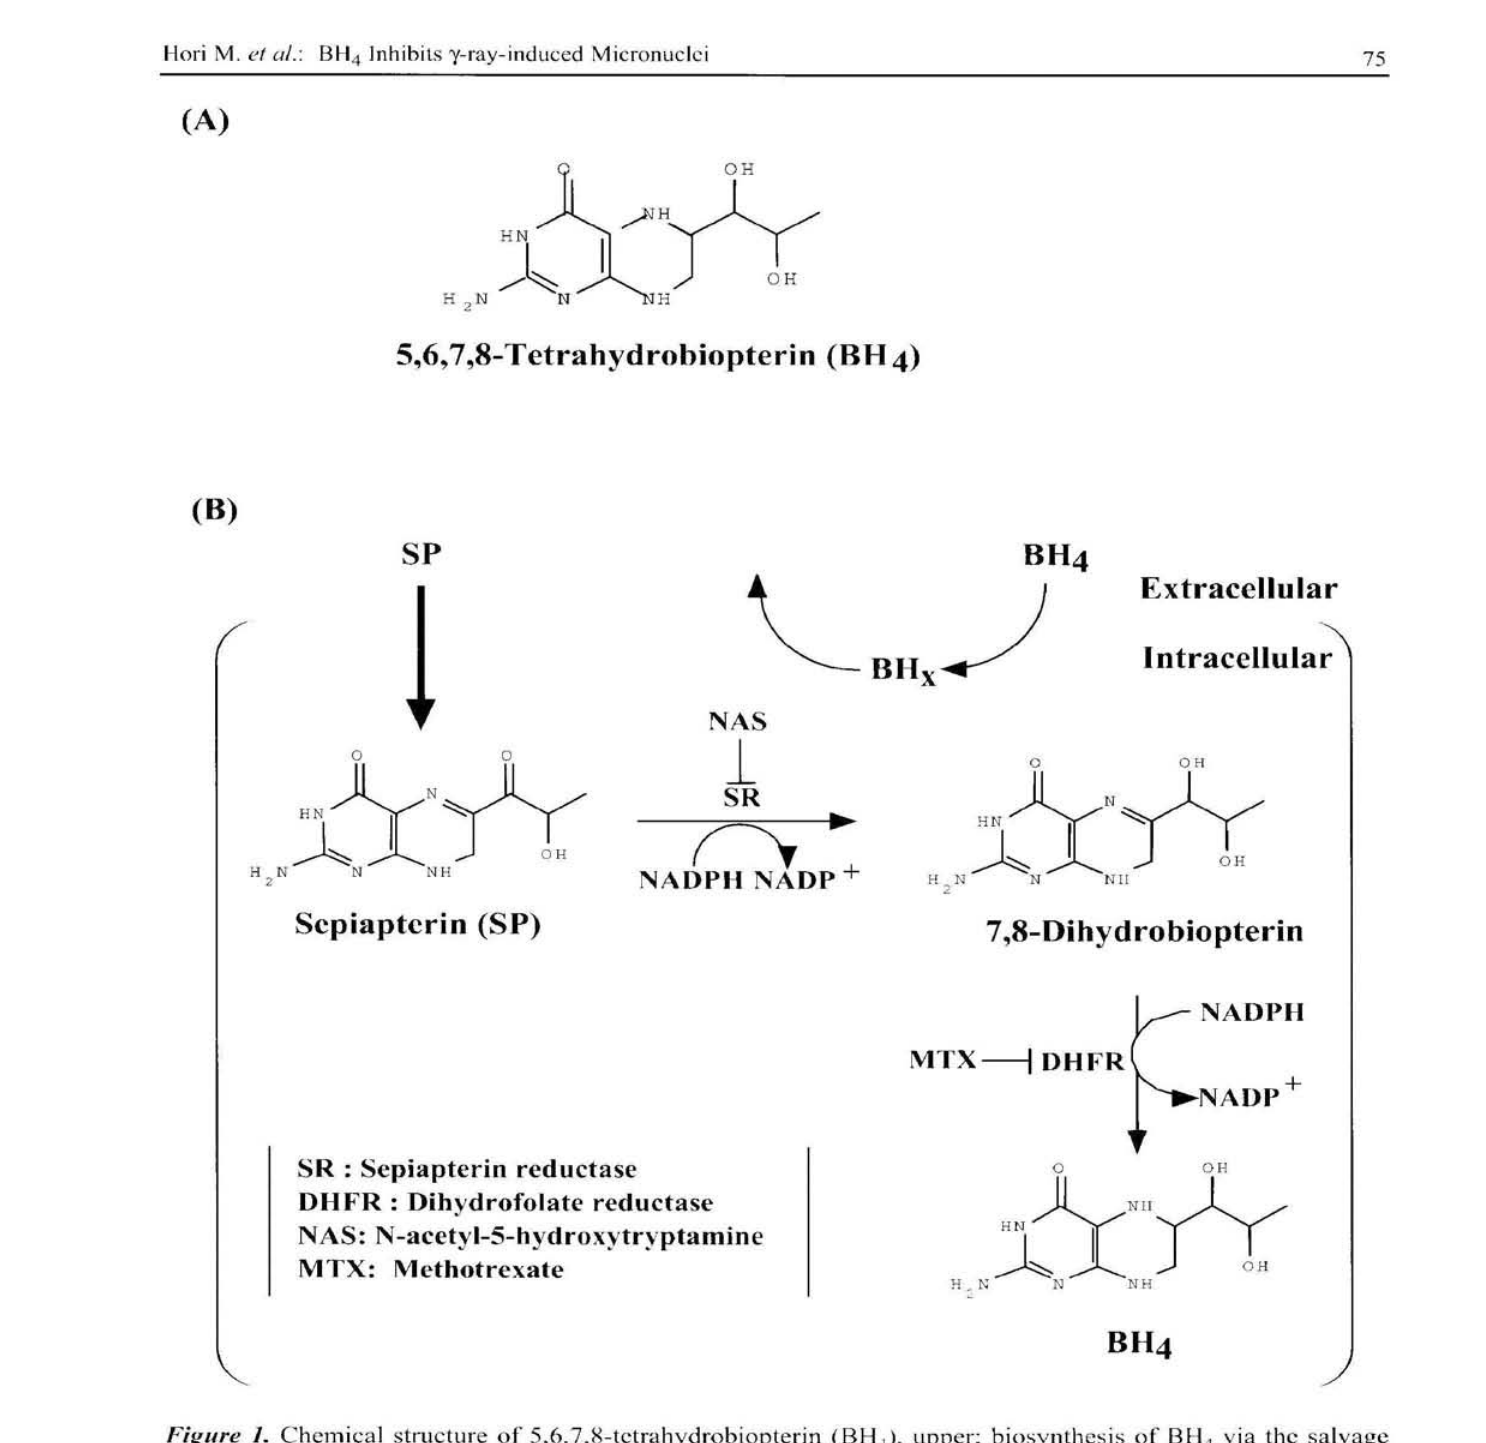
1. Chemical structure of 5,6,7,8-tetrahydrobiopterin (BH 4 ), upper; biosynthesis of BH 4 via the salvage pathway from sepiapterin (SP), lower induced MN frcqucncy in RAW264.7 cells was exam-